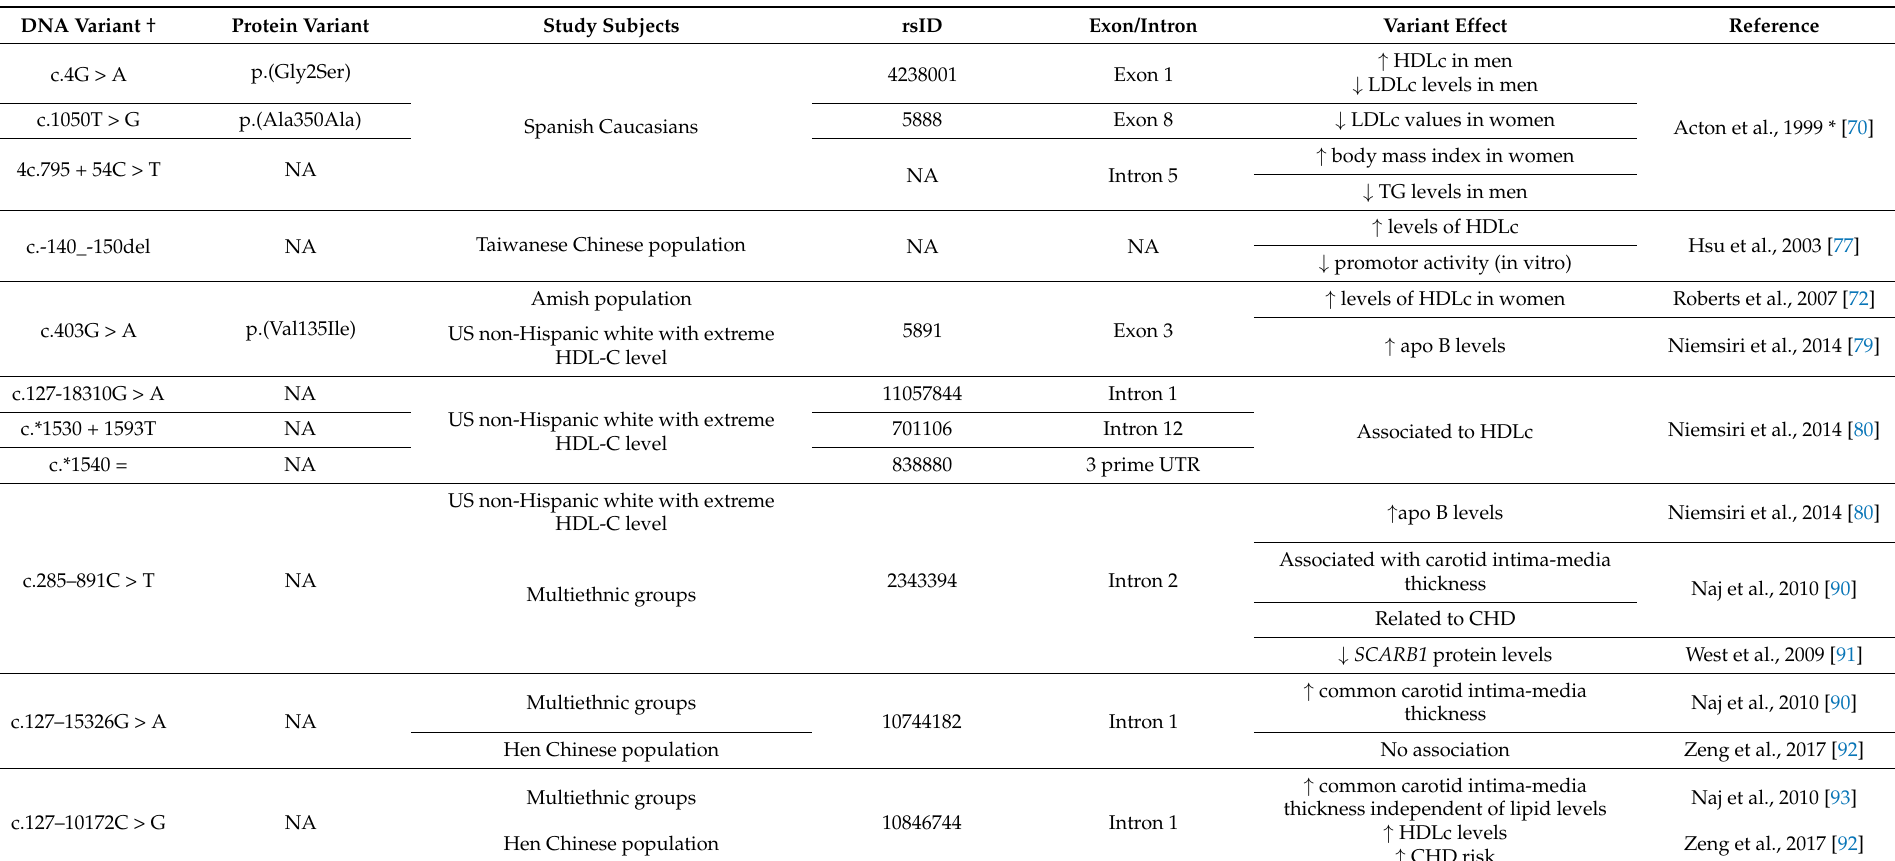
Table 2. Effects of SCARB1 gene variants on serum lipid profile. cDNA position was related to the SCARB1 gene (NM.005505.5; encoding SR-B1). † Nucleotide position 1 is the first nucleotide at the ATG initiation codon. * Acton et al., 1999 results are presented in this table since it was the first time that these variants were described, although several studies have shown different results. NA indicates not applicable. Apo, apolipoprotein; CE, cholesterol ester; CHD, coronary heart disease; CVD, cardiovascular disease; HDL, high-density lipoprotein; HDLc, high-density lipoprotein cholesterol; LDL, low-density lipoprotein; LDLc, low-density lipoprotein cholesterol; Lp(a), lipoprotein (a); SR-B1, scavenger receptor B class 1; VLDL, very low-density lipoprotein; ↓ decrease; ↑